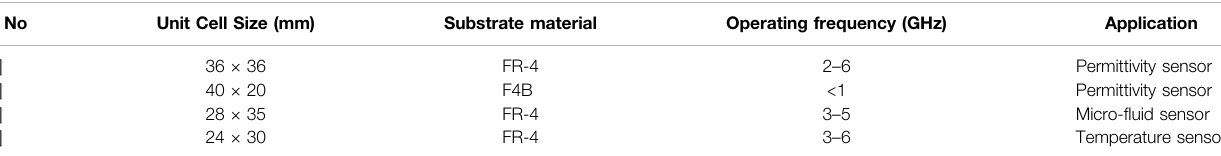
TABLE 2 | Performance Comparison of Metamaterial absorbers based Sensors in Microwave Range. Ref. No